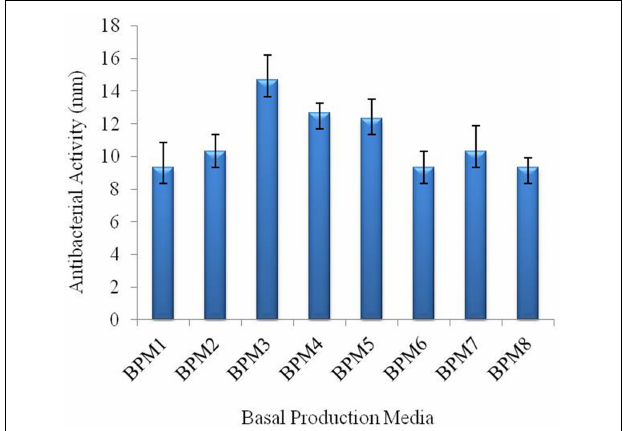
FIGURE 4 | Effect of eight different production media on antibacterial compound production in Streptomyces sp. JAJ13.